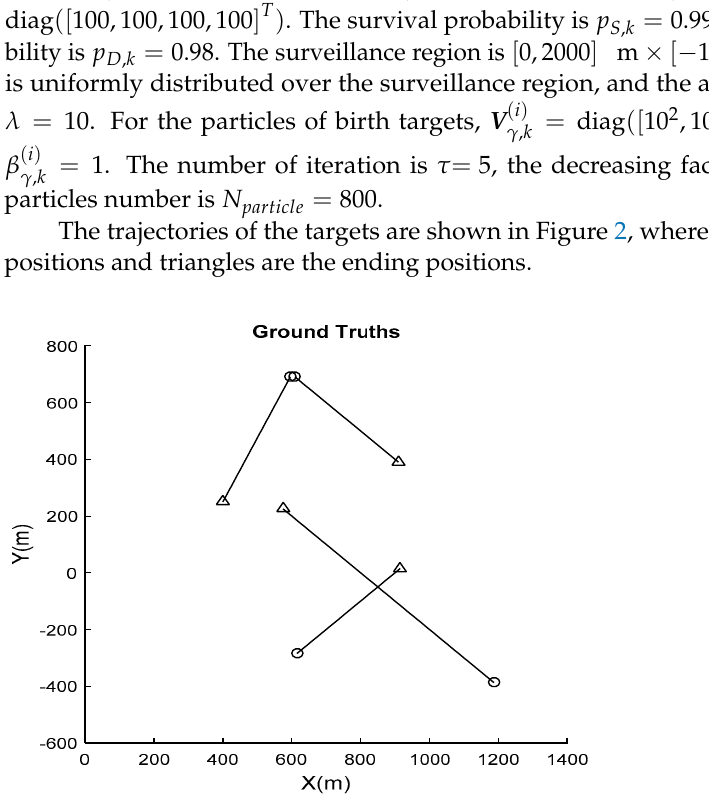
Figure 2. Trajectories of the targets.